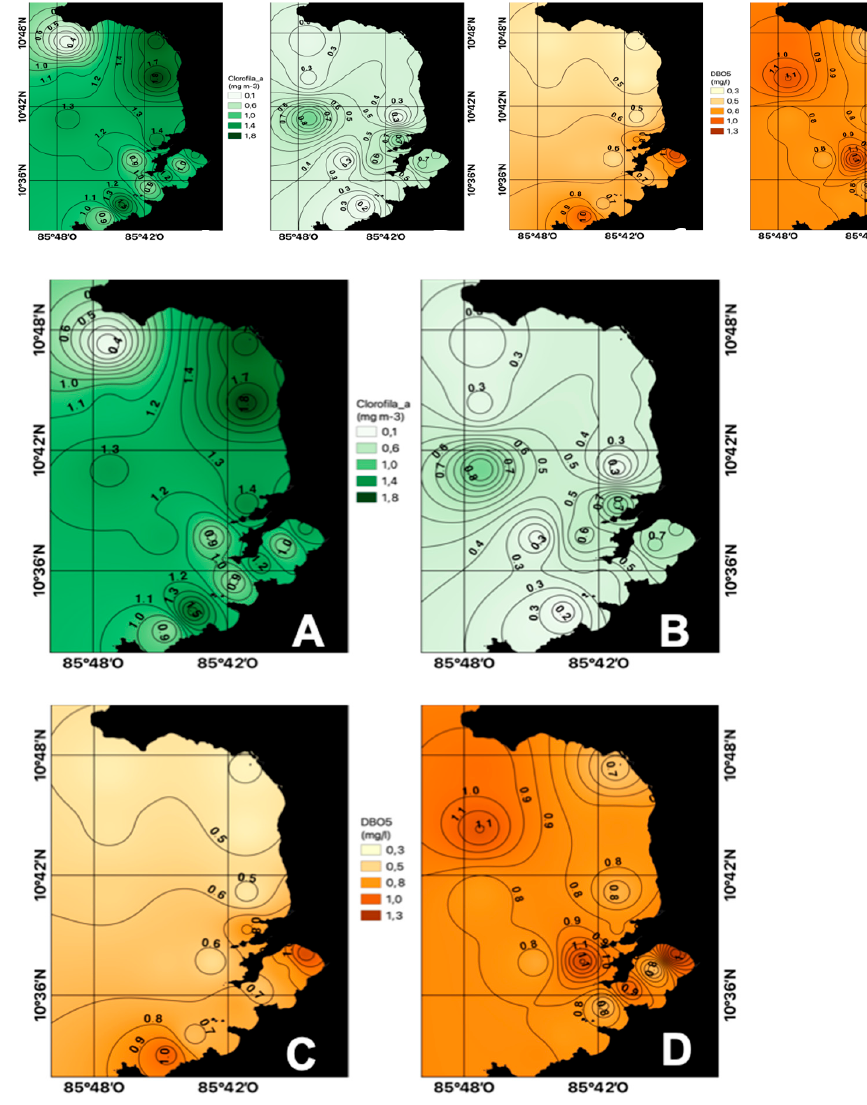
Figure 5. Spatial distribution of surface chlorophyll a (( A ) dry season, ( B ) rainy season) and surface BOD 5 (( C ) dry season, ( D ) rainy season) in the Gulf of Papagayo. In the Gulf of Papagayo in the dry season, the average BOD 5 concentration was 0.65 ± 0.23 mg L − 1 (Figure 5C), while in the rainy season, the values ranged between 0.63 and 1.28 mg L − 1 (Figure 5D) for an average of 0.88 mg L − 1 . This parameter is related to the oxygen consumed by microorganisms such as fungi, bacteria, and heterotrophic plankton